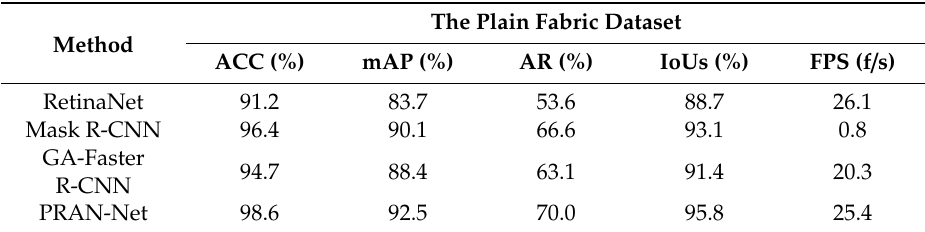
Table 4. The detection results of the four methods with the plain fabric